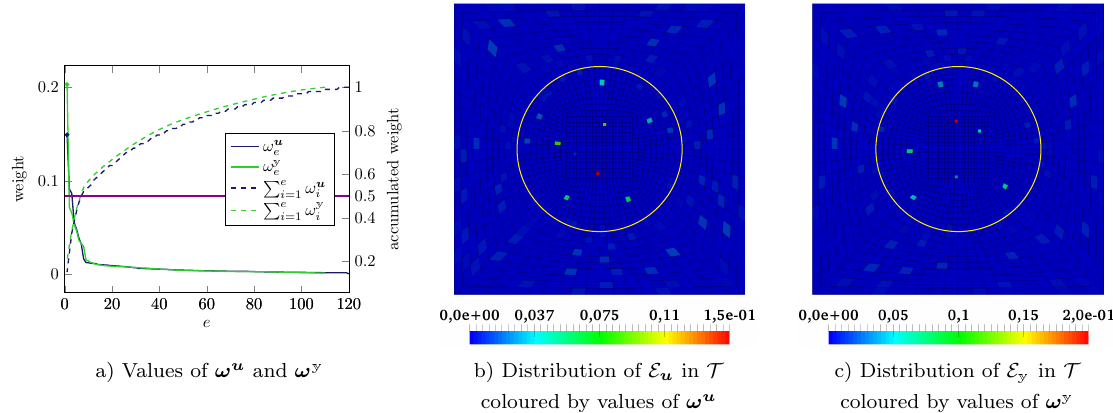
for reduced meshes and T E u E y